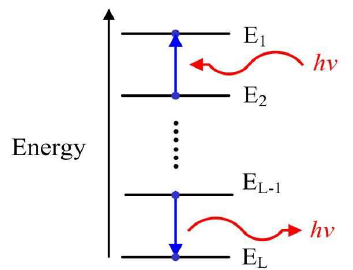
Figure 1. The concept of energy level in quantum mechanics. The electron in atom increases energy level from E 2 to E 1 by absorbing a photon or decreases energy level from E L − 1 to E L by emitting a photon, where the energy of the photon is hv